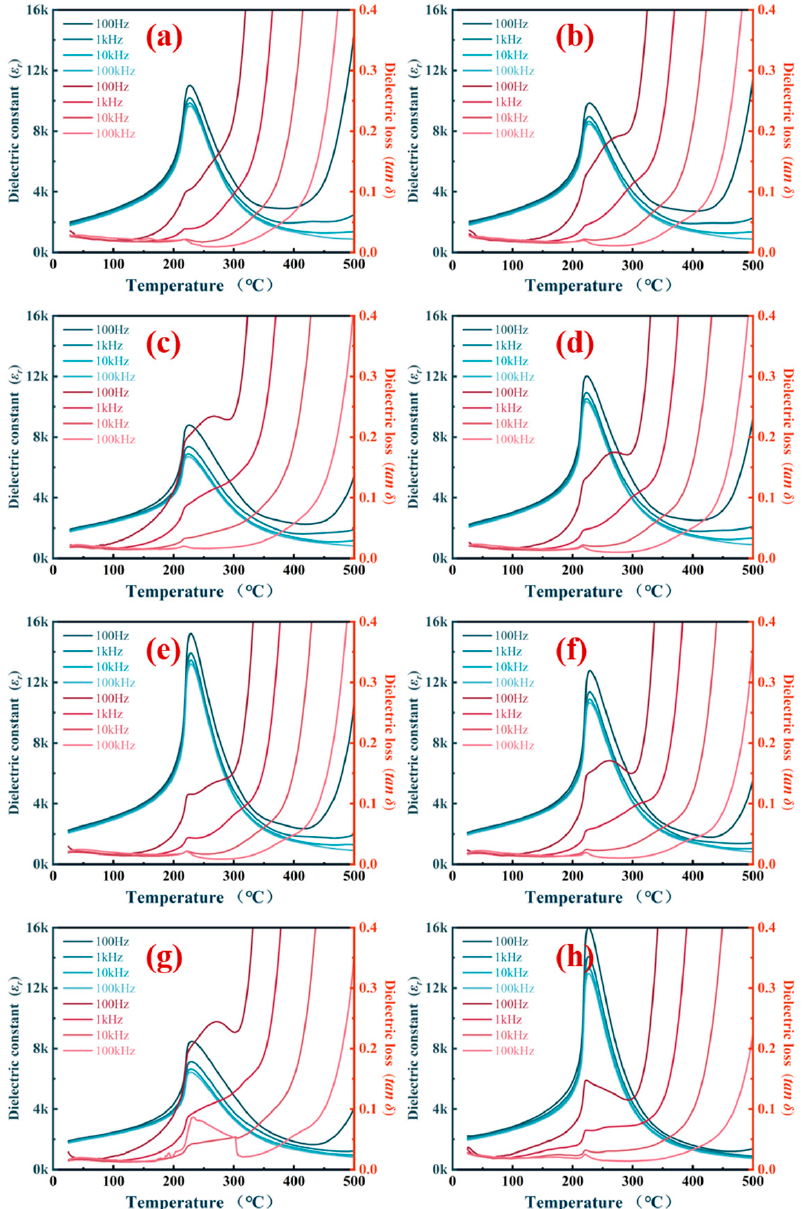
Figure 3. Dielectric property-temperature spectra of the 0.2 wt% Li 2 CO 3 -modified ceramics sintered at different temperatures: ( a ) 900 °C; ( b ) 920 °C; ( c ) 940 °C; ( d ) 960 °C; ( e ) 980 °C; ( f ) 1000 °C; ( g ) 1050 °C; ( h ) 1100 °C.